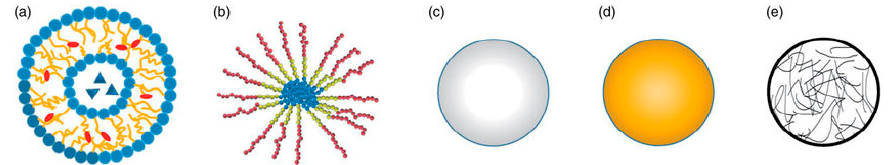
Figure 1. Representative structures of various NPs for drug delivery. ( a ) Liposomes, ( b ) polymeric micelles, ( c ) polymeric nanoparticle, ( d ) gold nanoparticle, and ( e ) nanogel. Reprinted from Wang et